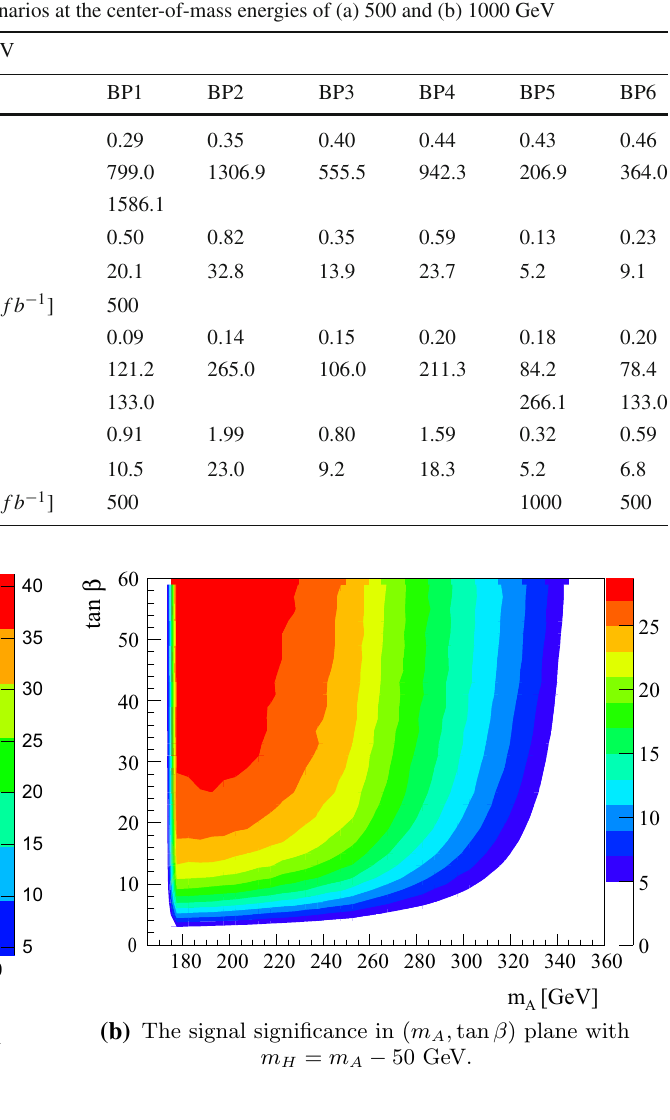
at a future linear collider like ILC at 0.5 and 1 TeV. The integrated luminosity was set to 500 f b − 1 for all selected benchmark points. Detector simulation was performed by DELPHES using SiD detector card. Results indicate that all selected points are in the reach of ILC with the possibility of mass reconstruction for both scalar and pseudo-scalar Higgs bosons at the same time with a single analysis. The cover- age in tan β direction reaches tan β = 60 with almost the same signal sensitivity for tan β higher than 10. The signal